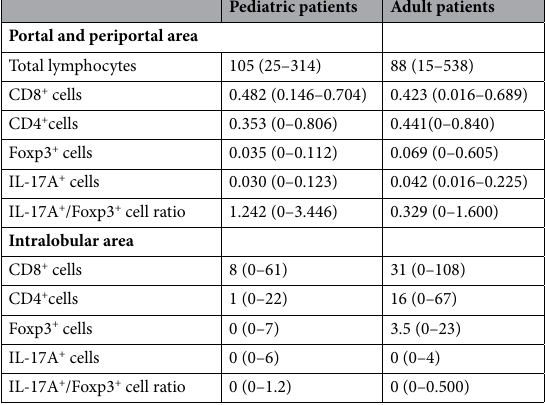
Table 2. Lymphocyte frequencies in NAFLD liver samples. Results are expressed as median